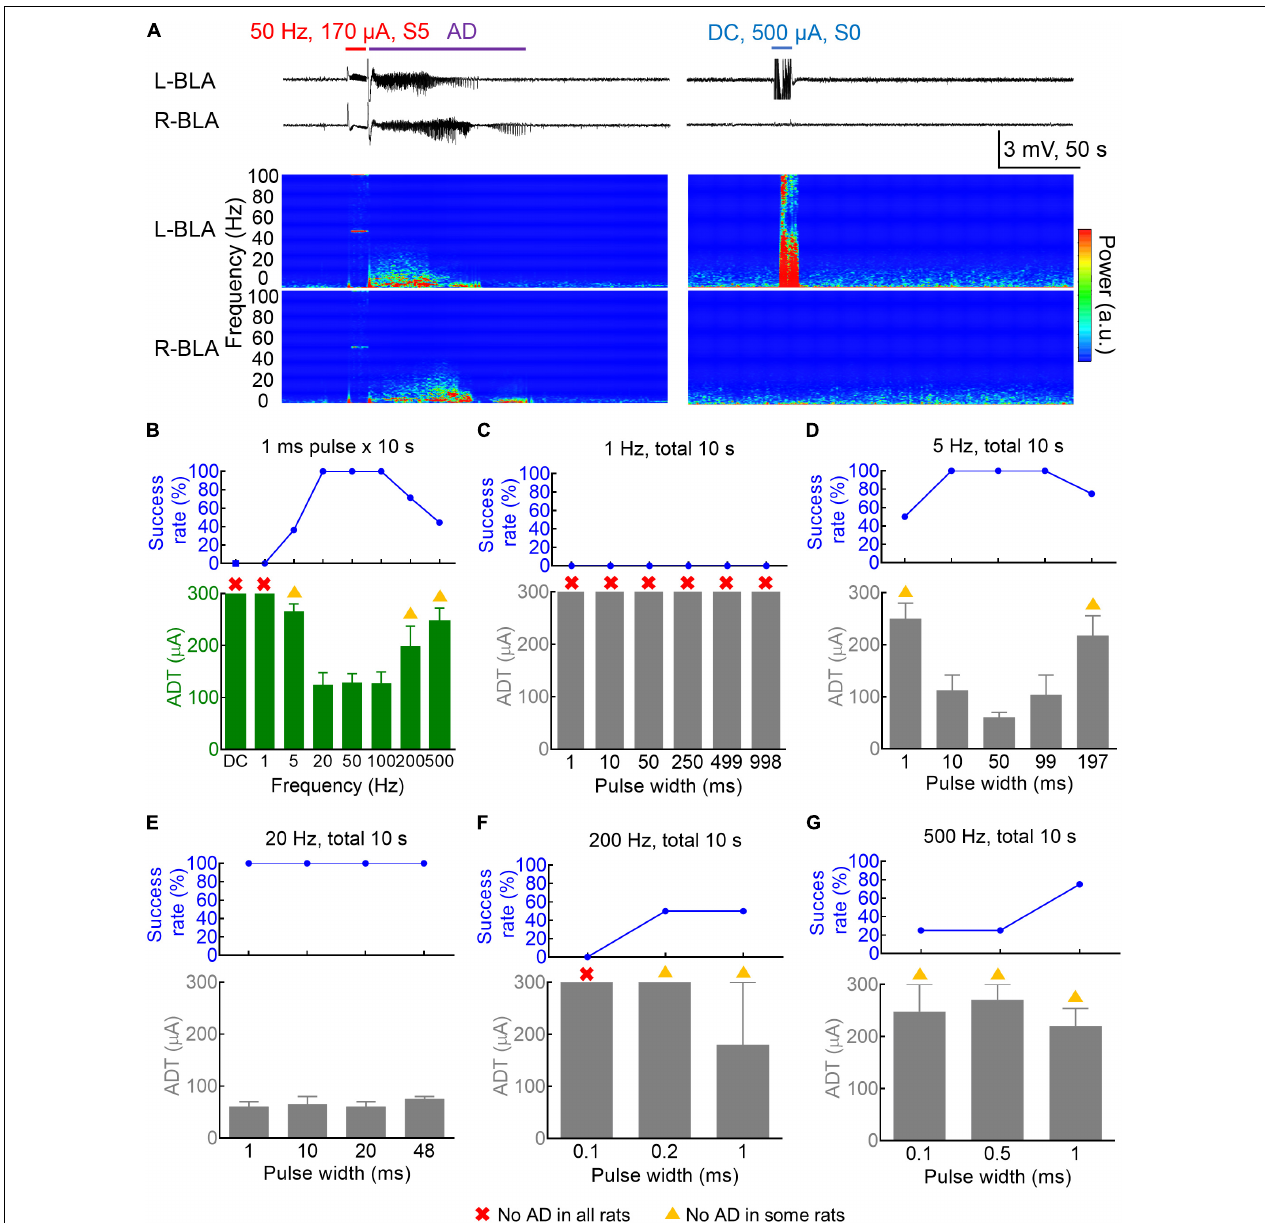
FIGURE 1 | Dependence of the amygdala kindling effect on the pulse frequency and pulse duration. (A) Left: The 50 Hz × 10 s ( ± 170 µ A) kindling stimuli (red) on the 3rd day readily elicit Racine S5 seizure behavior and afterdischarge (AD) in the bilateral basolateral amygdala (BLA). Samples of local field potential (LFP) (upper panels) and the spectrogram (lower panels) are shown. Right: DC × 10 s (blue) (500 µ A, the last session on the 4th day of kindling) elicits no AD or behavioral abnormality. (B) The AD threshold (ADT) at the left basolateral amygdala (L-BLA) (lower panel) was measured with different pulse frequencies ( n = 11, 9, 14, 7, 7, 9 for the 5, 20, 50, 100, 200, and 500 Hz, respectively). The success rate (upper panel) is 100% with 20–100 Hz stimulation, decreases with 5 and 200–500 Hz, and 0 with 1 Hz-pulse or DC stimulation. The red cross denotes that no AD could be elicited in any rats even with the highest currents (300 µ A). The yellow triangle denotes that no AD could be elicited in some rats. The axes and symbols are the same in the following: (C) No ADT could be defined for the 1 Hz stimulation ( n = 3) even in different pulse widths 1–998 ms. (D) The 5 Hz kindling stimuli are effective with a pulse width of 10–99 ms, but could also elicit AD with shorter and longer pulse width (1 and 197 ms) with lower success rates ( n = 4). (E) With 20 Hz frequency, AD could always be successfully induced with a wide range of pulse width (1–48 ms) ( n = 2). (F,G) High-frequency stimulation (200 and 500 Hz, n = 2 and 4) could successfully elicit AD with a pulse width of 1 ms or even < 1